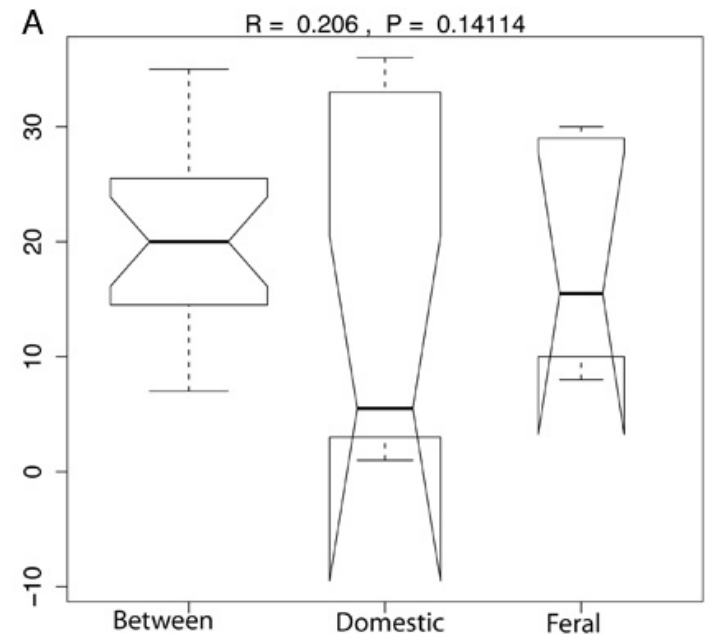
Figure S4. Analyses of similarities (ANOSIM) with dissimilarity ranks between and within domestic and feral goats. A) Boxplots of analyses of dissimilarity ranks. B) Boxplots of analyses of dissimilarity ranks without one domestic group